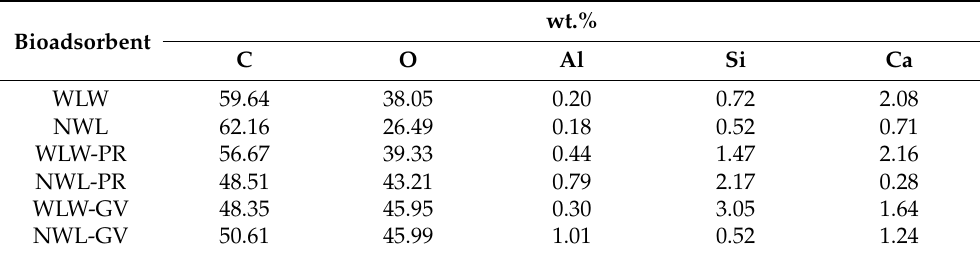
Table 11. Elemental analysis of WL treated with water and NaOH.